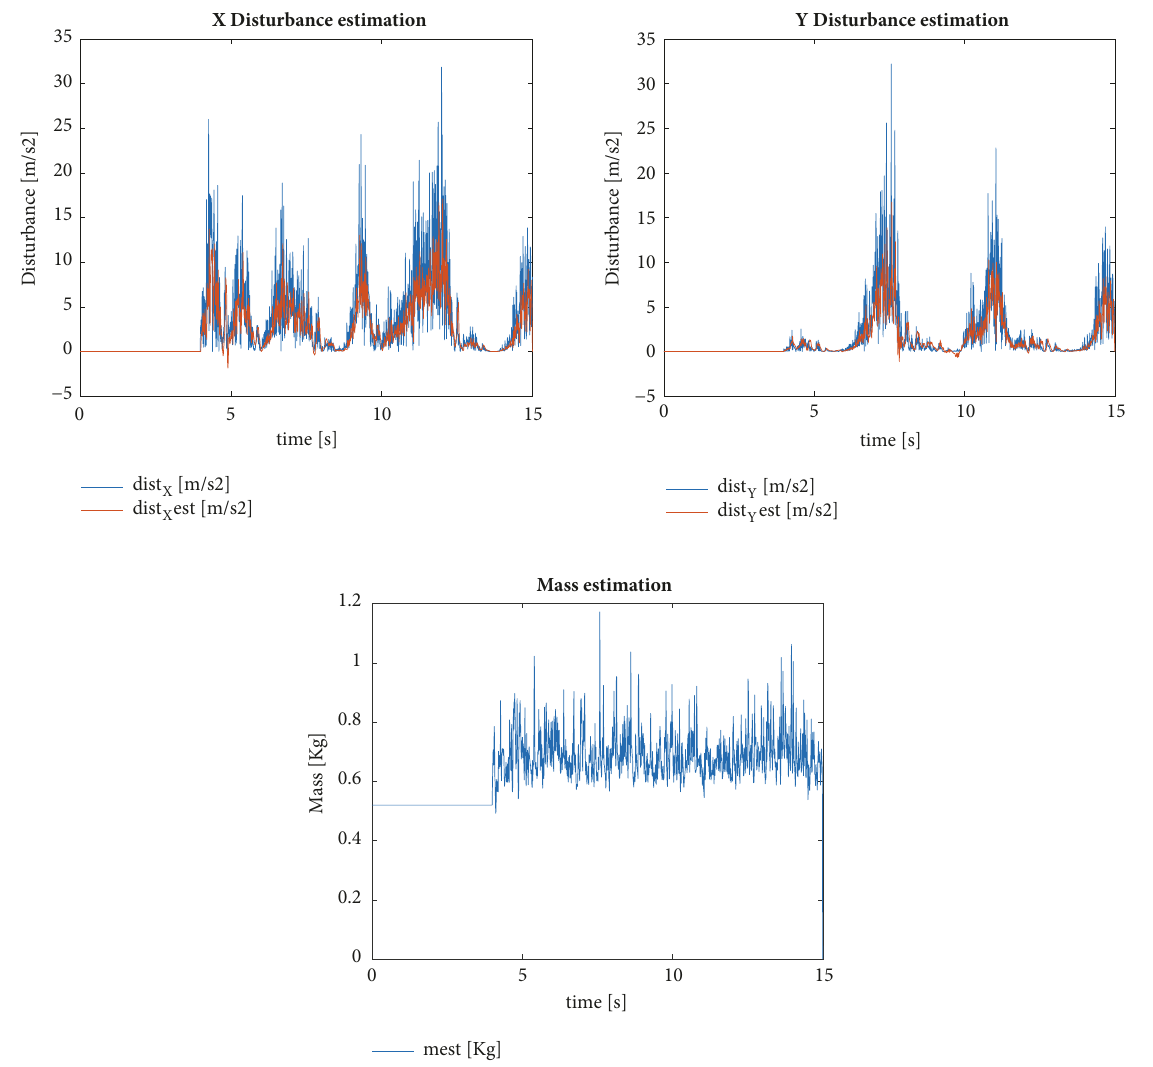
Figure 19: Wind disturbance estimation in the x- and y-axis, top, and mass estimation (bottom).